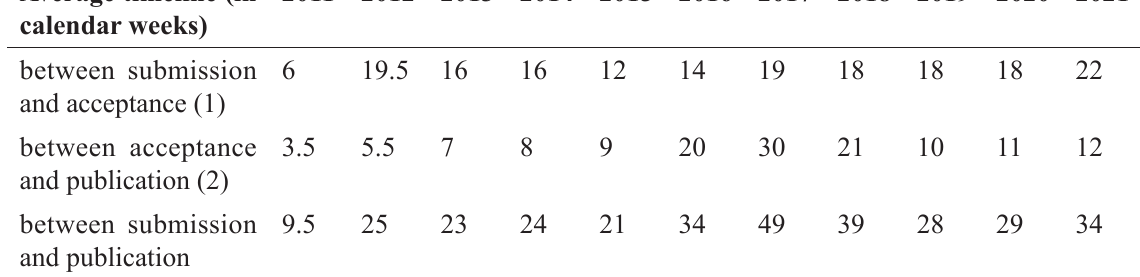
Table 5. Timeline of publication in calendar weeks between the 1) peer review and revision process, and 2) editorial process and